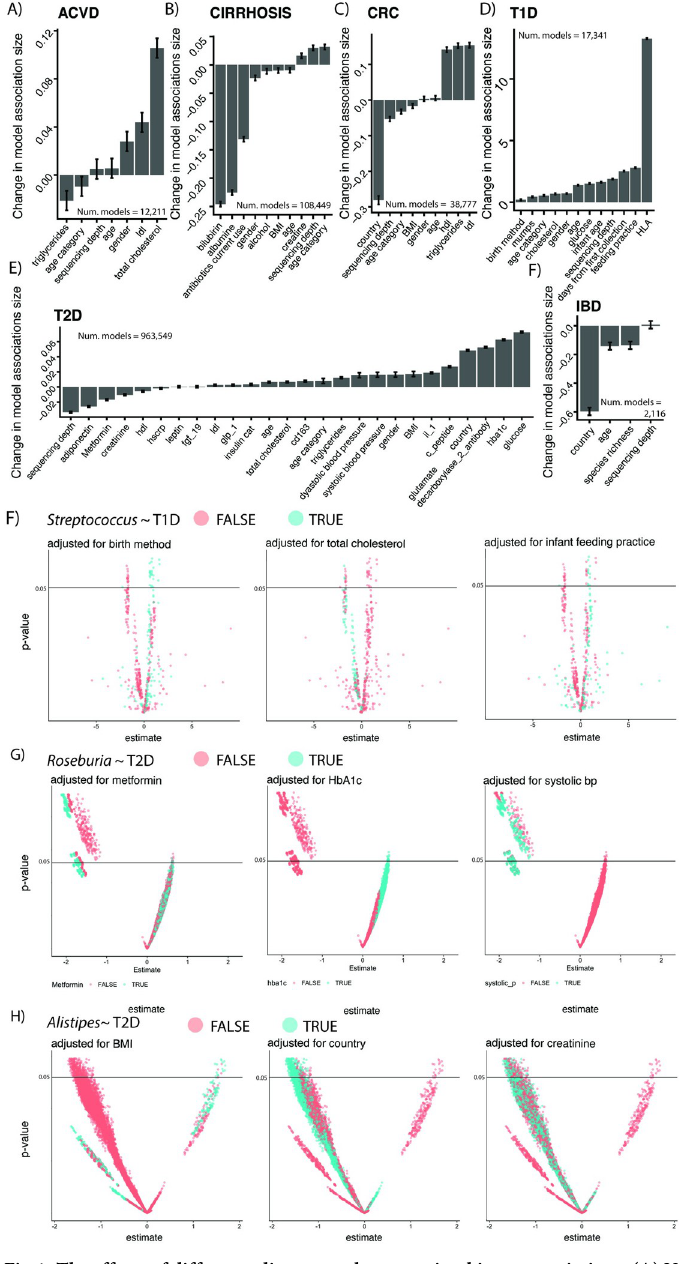
Fig 4. The effects of different adjusters on human microbiome associations. (A) Various adjusters for our diseases of interest. For each disease in our study, we report the change in the association sizes between microbiome features and disease as a function of adjusting variable presence or absence (See Methods). Each individual plot summarizes the output for the 2^n models fit for each feature within a given disease, where n = number of adjusters. The y-axis corresponds to the mean change in Beta coefficient (in units of relative abundance) on the independent, binary disease outcome when a given adjusting variable (x-axis) is included in the model. (B–D) Visualization of the impact of the presence/absence of different confounders for 3 organisms and their associations with T1D/T2D. This figure can be generated using the code deposited in https://github.com/chiragjp/ubiome_robustness and the data deposited in https://figshare.com/projects/Microbiome_robustness/127607. ACVD, atherosclerotic cardiovascular disease; BP, blood pressure; CRC, colorectal cancer; IBD, inflammatory bowel disease; T1D, type 1 diabetes; T2D, type 2 diabetes.